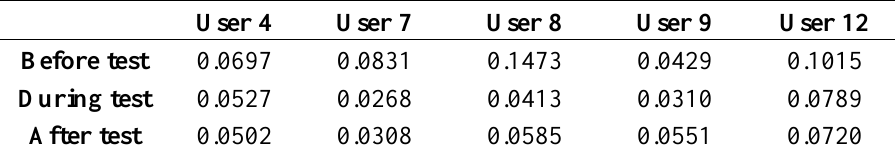
Table 22. Standard deviation of the heart rate in Stroop test.